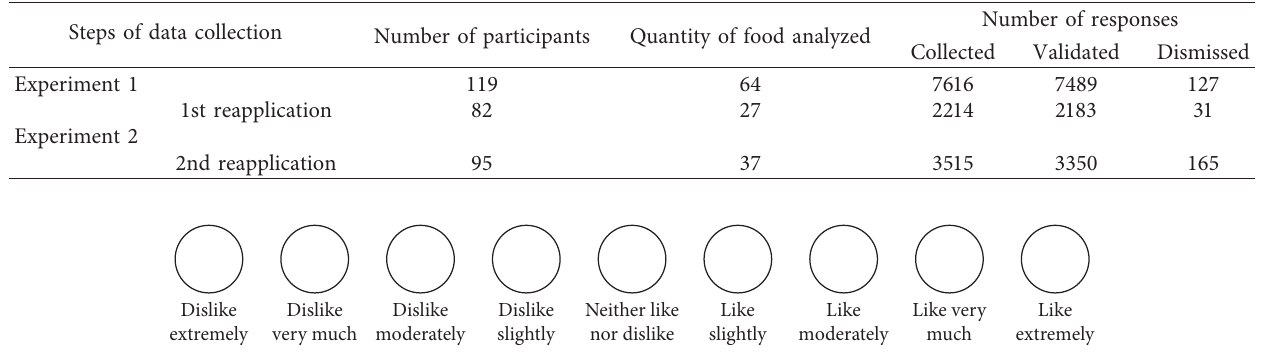
Figure 5: 9-point hedonic scale used in food preference data collection. Table 5: Correspondence between the central value of each category and the linguistic variables presented to the participants. Index of the label at the center point ( n )